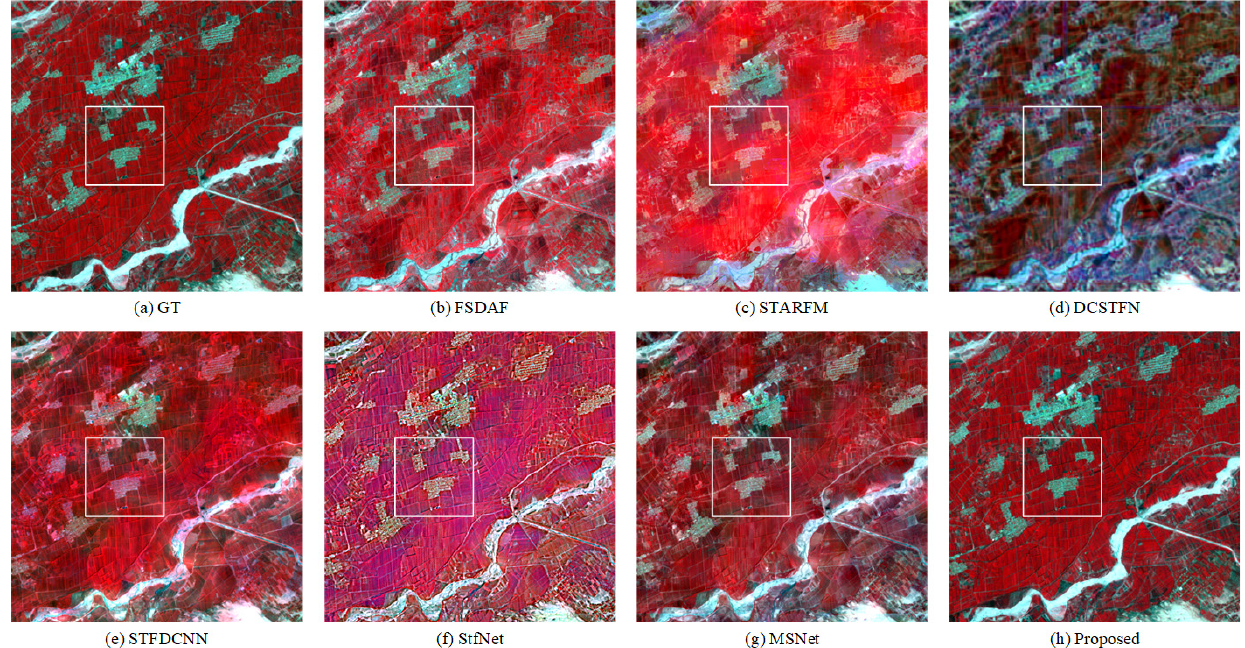
Figure 11. Complete prediction results for the target Landsat image (7 July 2015) in AHB dataset. Comparison methods include FSDAF [11], STARFM [8], DCSTFN [23], STFDCNN [18], StfNet [19], and MSNet [36], which are represented by ( b – g ) in the figure respectively. ( a ) represents the ground truth (GT), and ( h ) represents the proposed method.